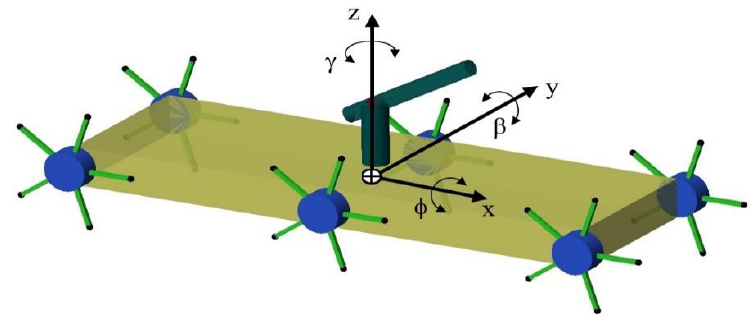
Figure 8. Euler angles of the robot body center.